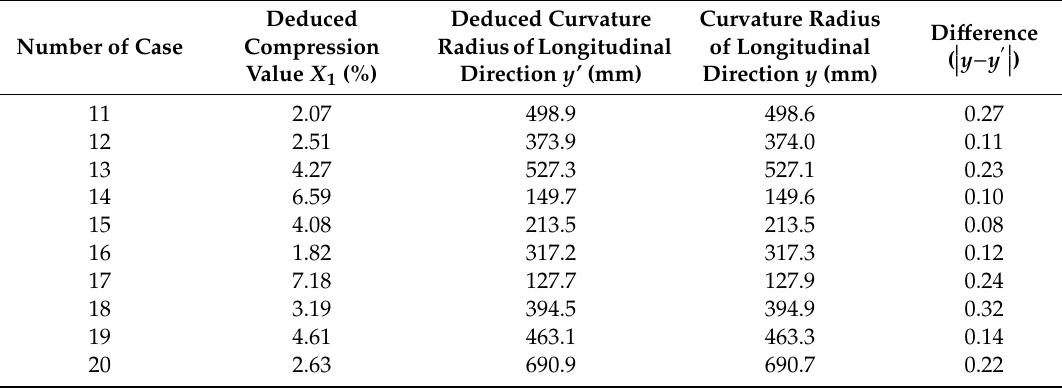
Table 11. Deduced results of the compression condition for the saddle